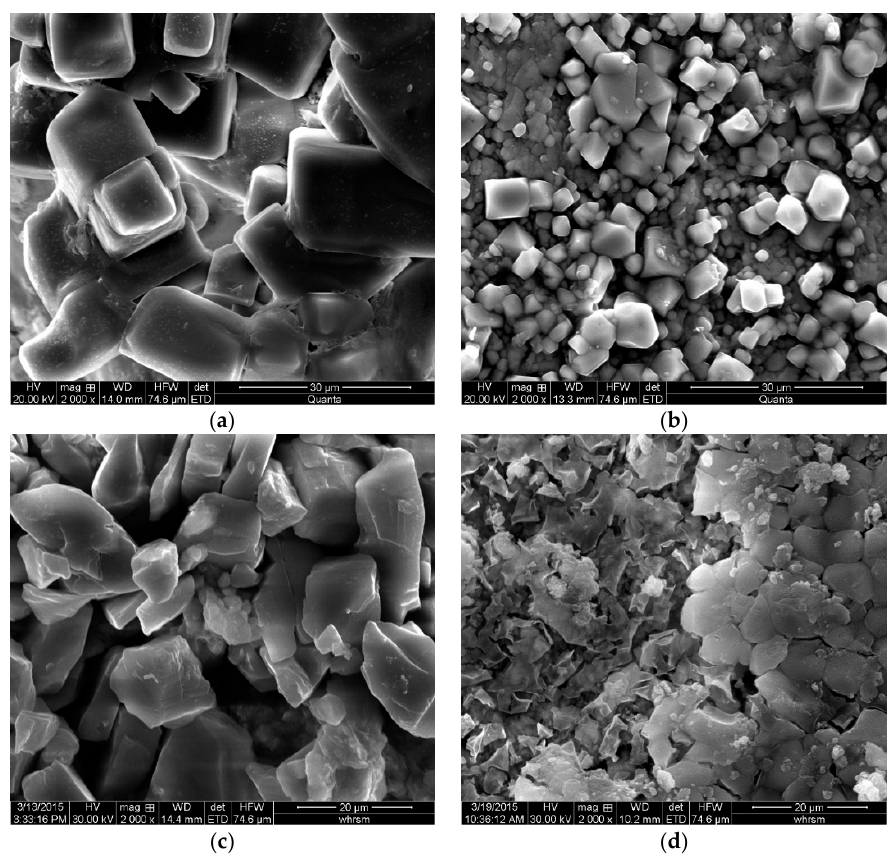
Figure 13. SEM pictures (2000 times). ( a ) Natural pure rock salt; ( b ) synthetic pure rock salt; ( c ) natural pure mudstone; ( d ) synthetic pure mudstone.